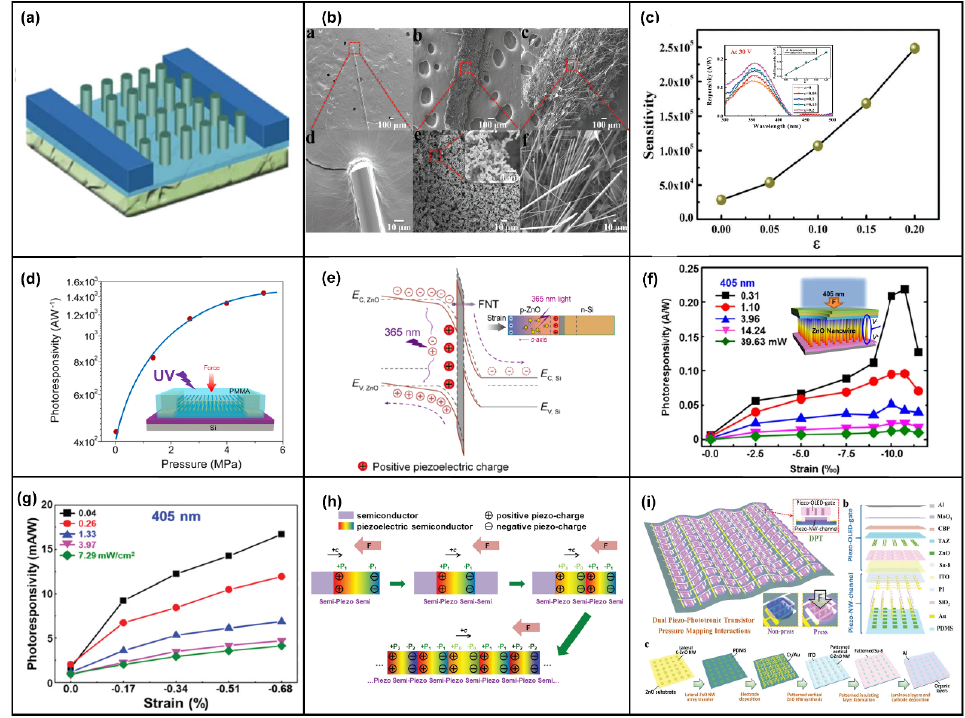
Figure 7. Device structure and characterization of the M-S-M and multilayer structure formed by ZnO NWs. ( a ) Schematic illustration of Ag–ZnO–Ag photodetector. Reproduced with permission from [197]. Copyright (2018) Royal Society of Chemistry Advances . ( b ) Field-emission scanning electron microscopy images of as-synthesized ZnO microarchitectures: ZnO microwire, ZnO coral-like microstrip, and ZnO fibril-like clustered microwire. Reproduced with permission from [199]. Copyright (2018) Small . ( c ) Sensitivity as a function of the tensile strain. Inset: responsivity spectra of the photodetector with different tensile strains under 30 V. Reproduced with permission from [200]. Copyright (2019) Advanced Materials Interfaces . ( d ) Photoresponsivity of ZnO photodetector as a function of applied pressure at M-S contact. Inset: device structure. Reproduced with permission from [203]. Copyright (2021) Nano Energy . ( e ) Schematic band diagrams of the piezo-phototronic effect in p-ZnO/Al 2 O 3 /n-Si junction. Reproduced with permission from [212]. Copyright (2021) Nano Energy . ( f ) The photoresponsivity at a bias of − 2 V as a function of the compressive strain under different illuminant powers for 405 nm laser illuminations. Inset: 3D schematic device of the n-Si/n-ZnO/p-PEDOT: PSS tri-layer structure. Reproduced